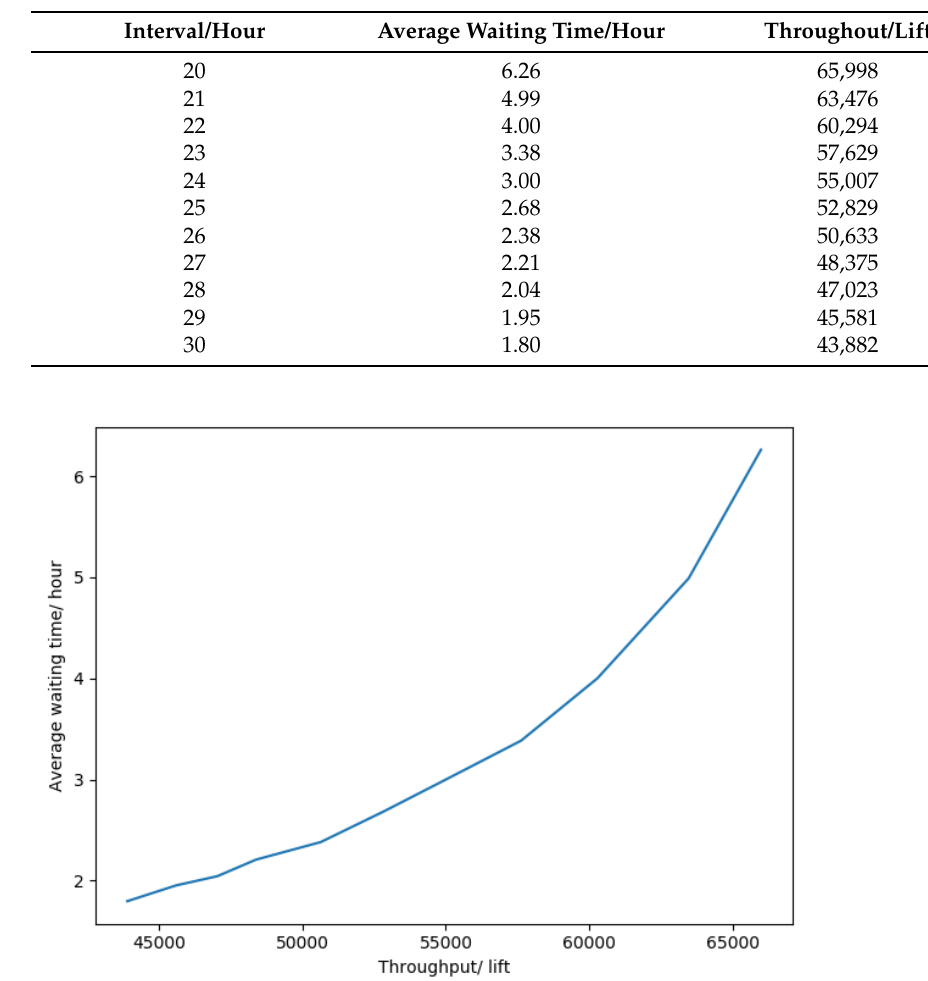
Table 1. Results under different time vessel intervals.